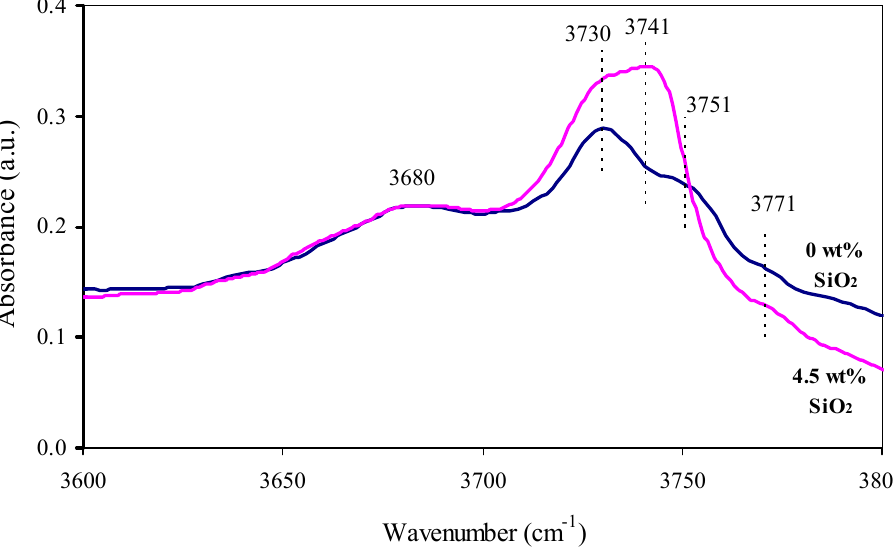
Figure 4. IR spectra of initial alumina support and a support containing 4.5 wt % SiO 2 .